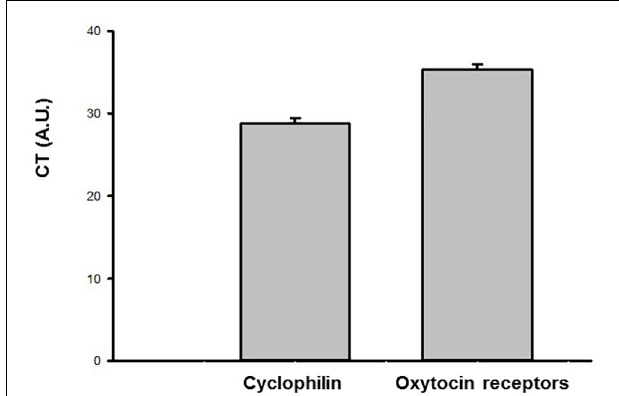
FIGURE 8 | Ct values (arbitrary units, A.U.) obtained by qPCR for the oxytocin (OT) receptor and endogenous housekeeping gene (Cyclophilin A) in the urinary bladder samples of sham animals ( N =